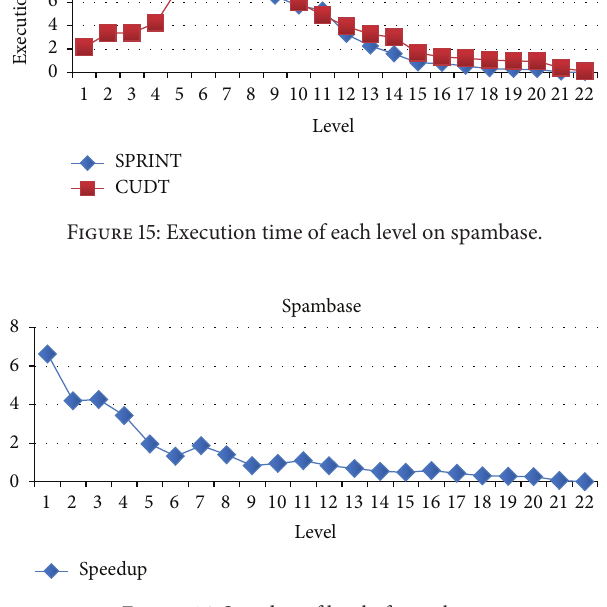
Figure 16: Speedup of level of spambase.